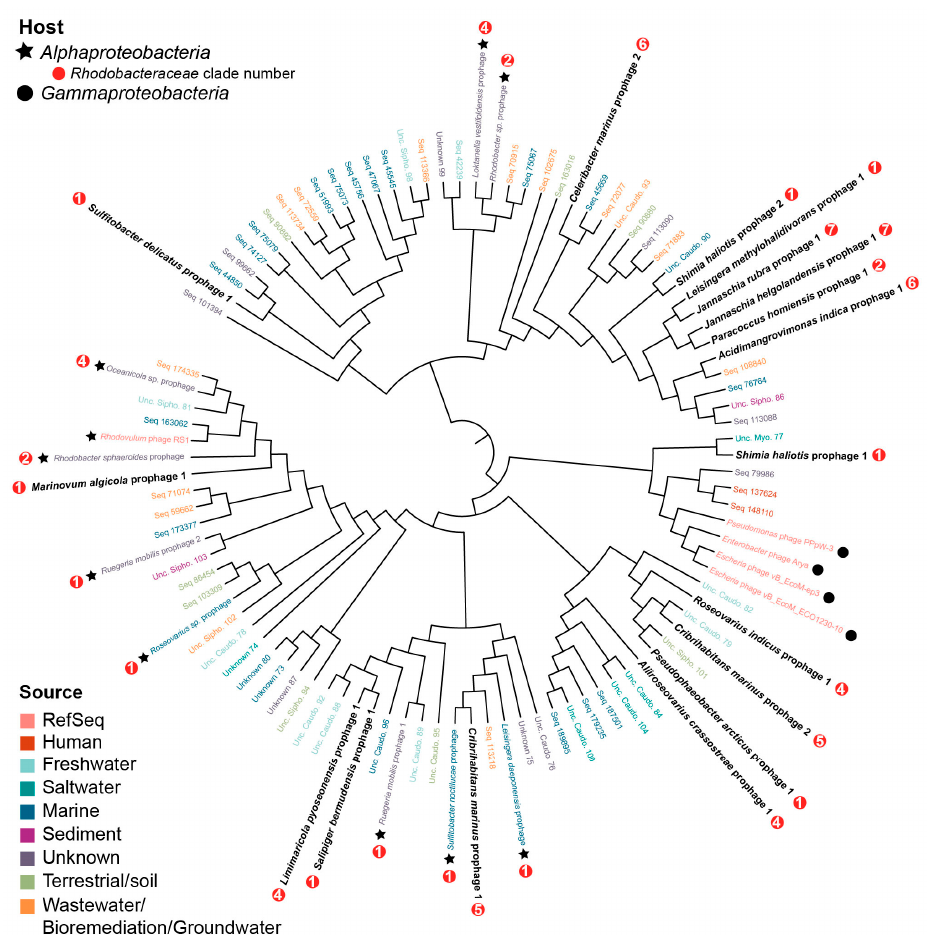
Figure 5. Roseobacter prophages represent novel viral groups. The tree shows in bold the 17 prophages identified in this study that had sequence similarities with the GL-UVAB and IMG/VR 3.0 viruses. The clade numbers of their roseobacter hosts (according to Simon et al., 2017) are labeled with a red circle. Among GL-UVAB and IMG/VR 3.0 viruses, the colors of sequence IDs indicate their environmental source. The star or circle indicates the predicted host. Leaf labels starting with Seq are from the GL-UVAB database, and leaves labeled Unknown represent IMG/VR database sequences (Table S3). For viruses with predicted taxonomy and/or predicted hosts, the lowest taxonomic level is